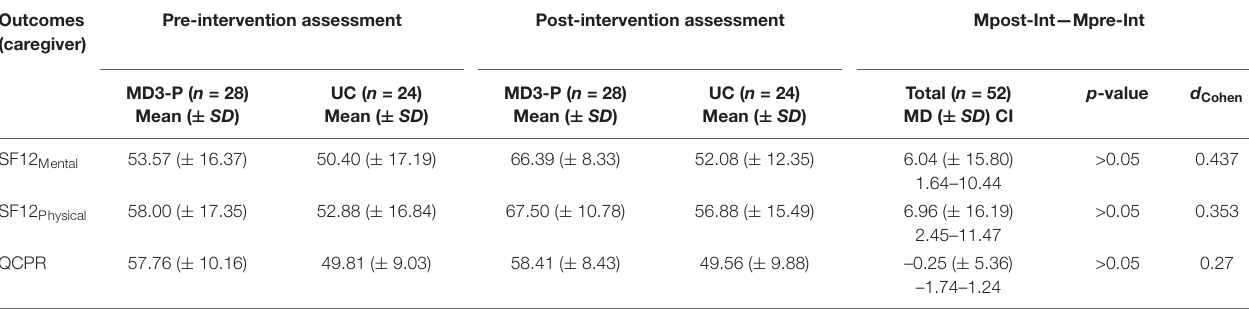
TABLE 5 | Mean outcome scores for the MD3-P group and total pre- and post-intervention mean differences for caregiver. Outcomes